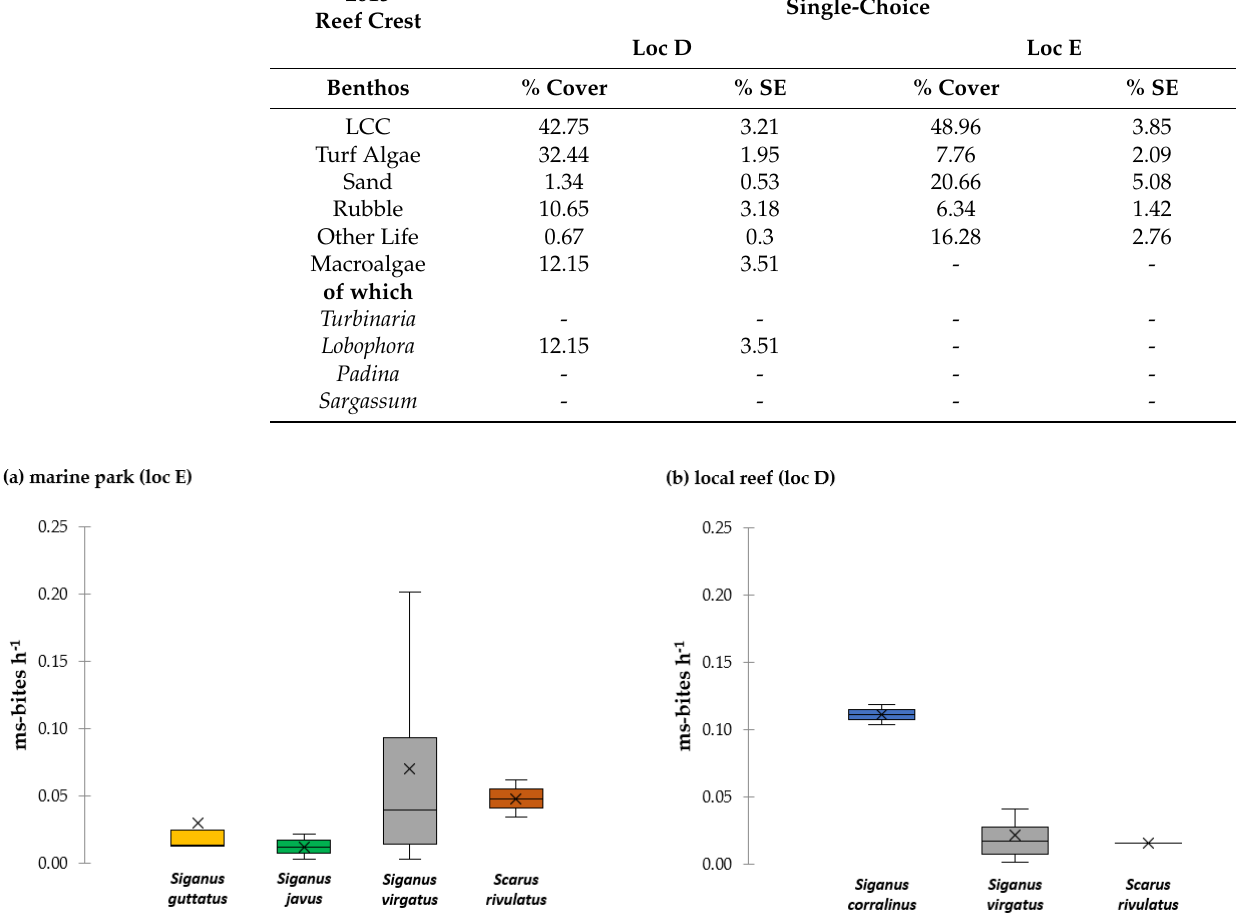
Figure 3. Bite rate (ms-bites h − 1 ) for recorded fish species in single-choice assays on the reef crest in the marine park (loc E) ( a ) and in a local reef (loc D) ( b ) in 2015. Fish species are color-coded. The boxplot shows the median and 25% quantile, the black cross indicates the mean.